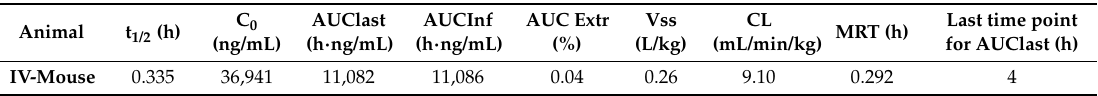
Table 5. Pharmacokinetic parameters of NUC013 after intravenous (IV) administration in mice. Pharmacokinetic parameters were obtained from the non-compartmental analysis of the plasma